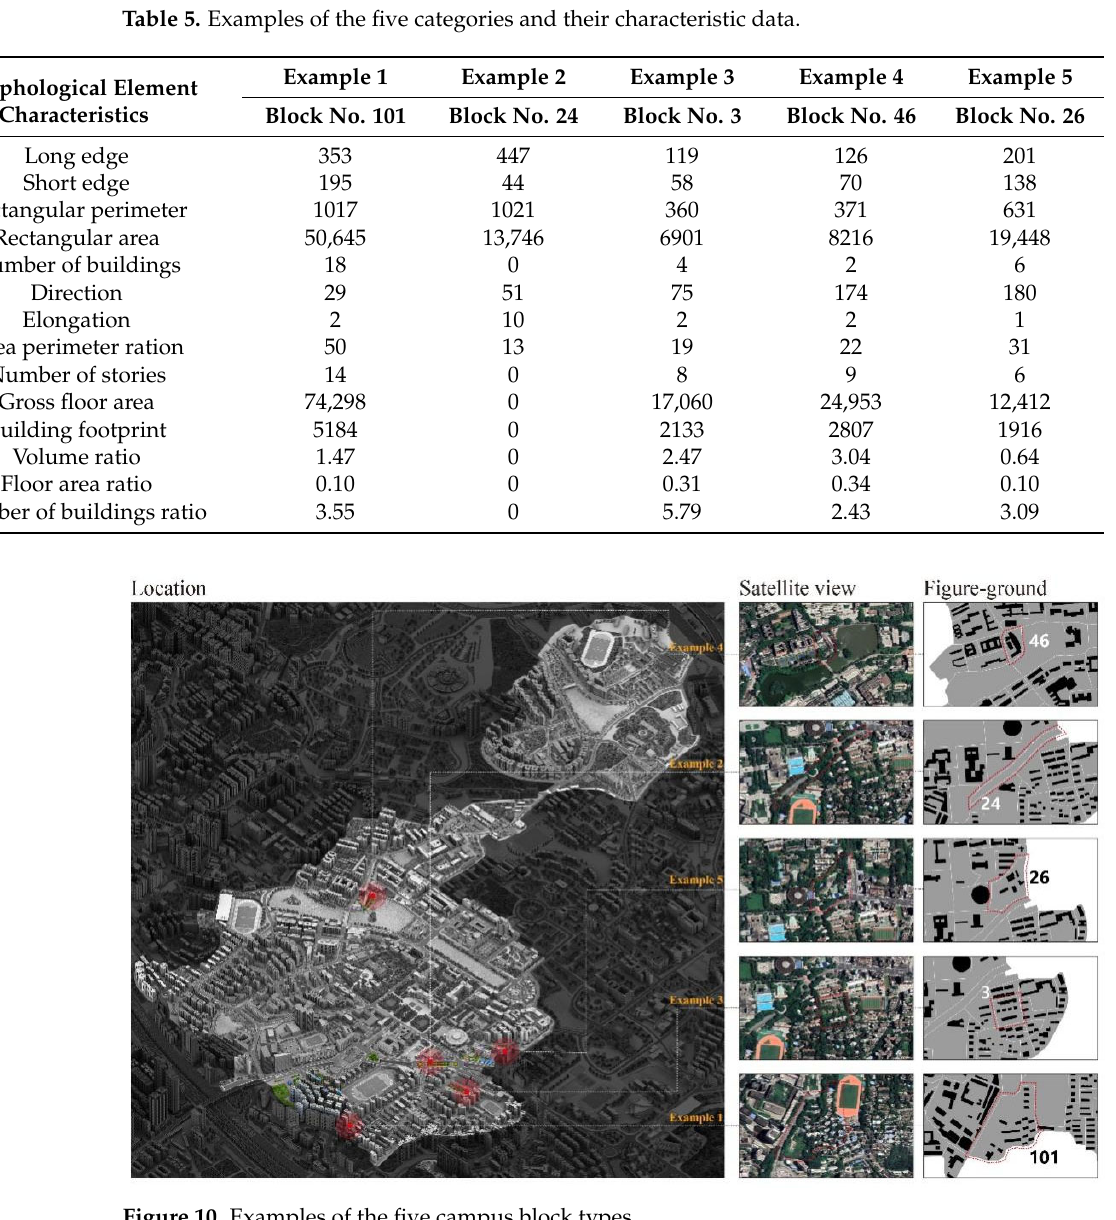
Figure 10. Examples of the five campus block types. For the representation of the characteristics of the campus block form of Wushan campus of SCUT, the natural breaks in the GIS platform were used to categorize risk for each feature data as “high”, “relatively high “, “relatively low”, and “low”. The proportion of each category was then counted and compared to the total level of the Wushan campus of SCUT to establish the category’s primary and distinctive